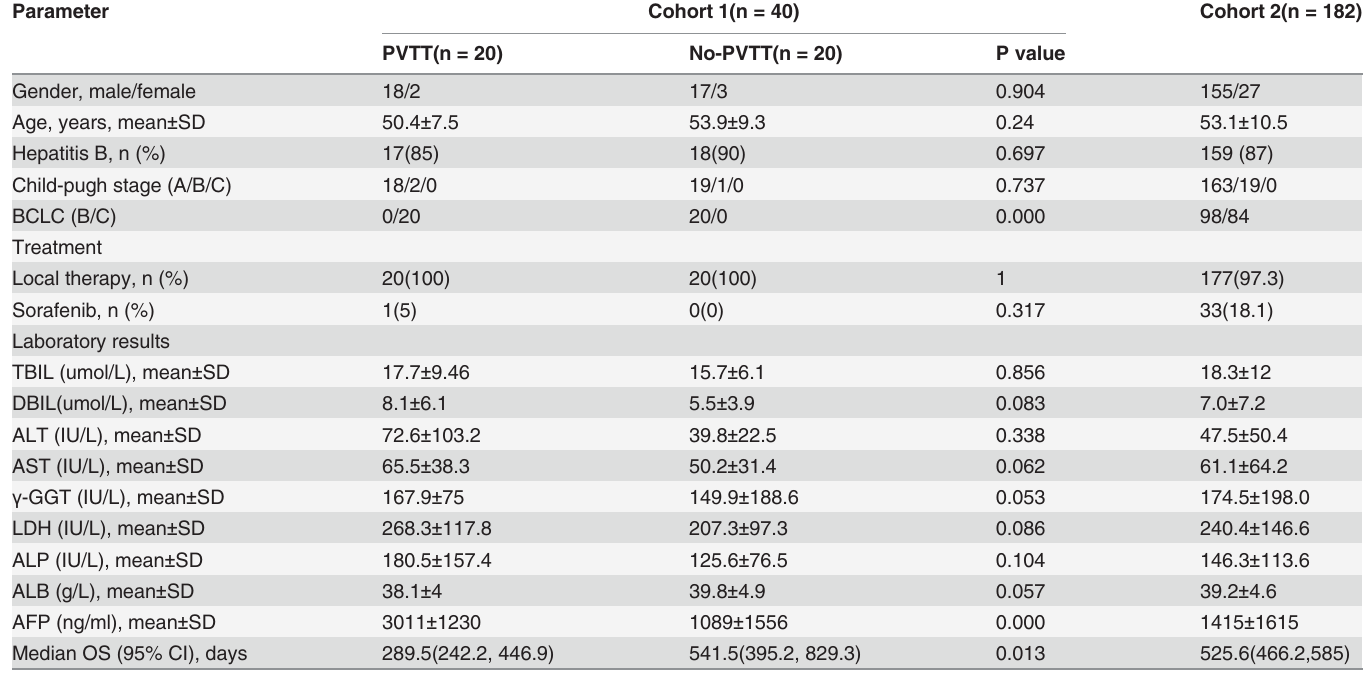
Table 1. Patients ’